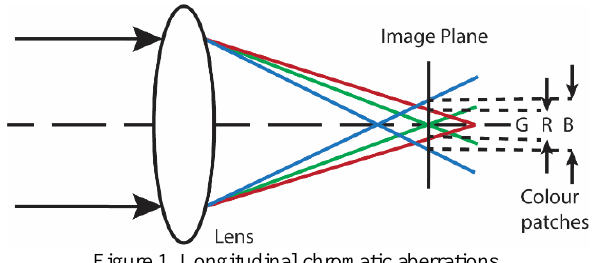
Figure 1. Longitudinal chromatic aberrations.